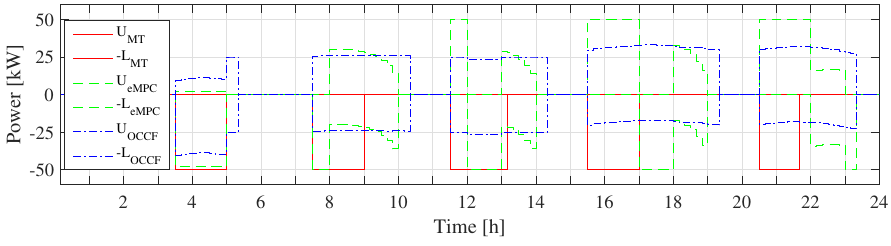
Figure 6. Flexibility capacity provided by charger 1.